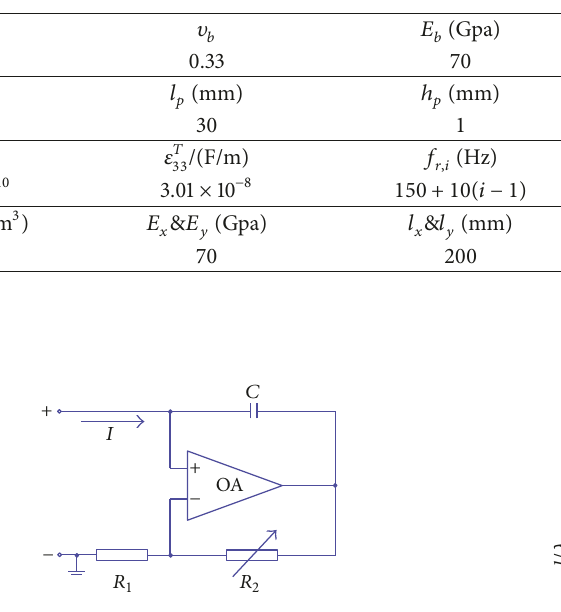
Figure 6: Equivalent negative-capacitance circuit.